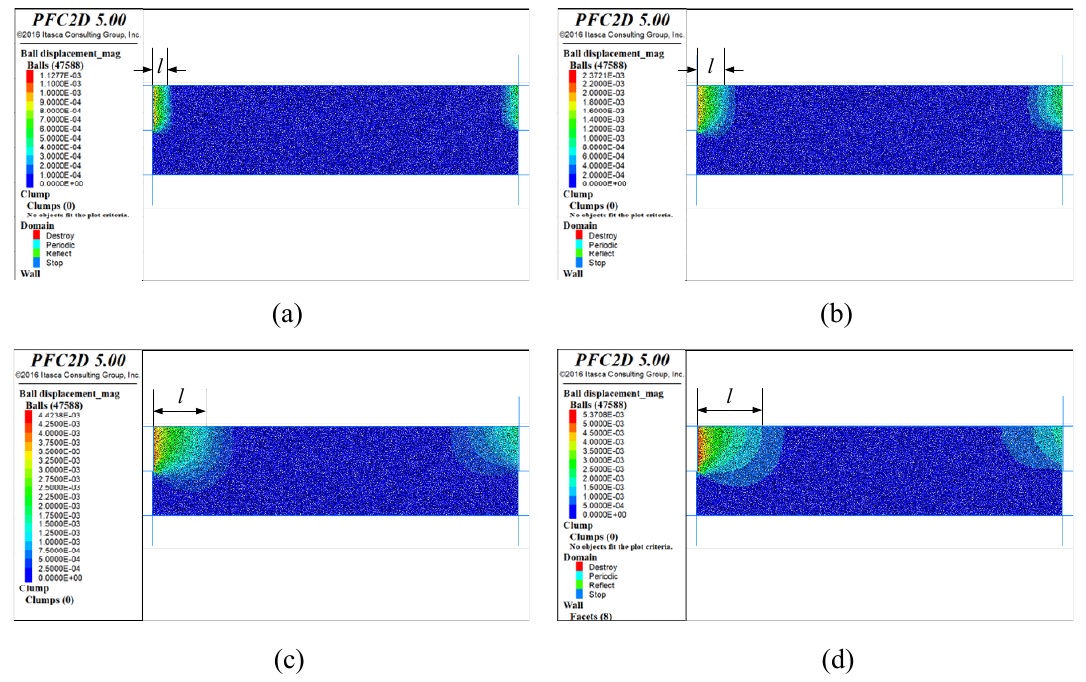
Figure 15. Range of soil affected by shear: ( a ) j = 1 mm; ( b ) j = 5 mm; ( c ) j = 10 mm; ( d ) j = 15 mm.